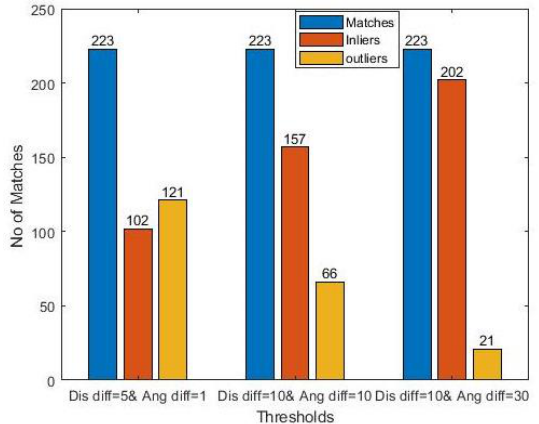
Figure 8 . The relation between the threshold value and the number of inliers.